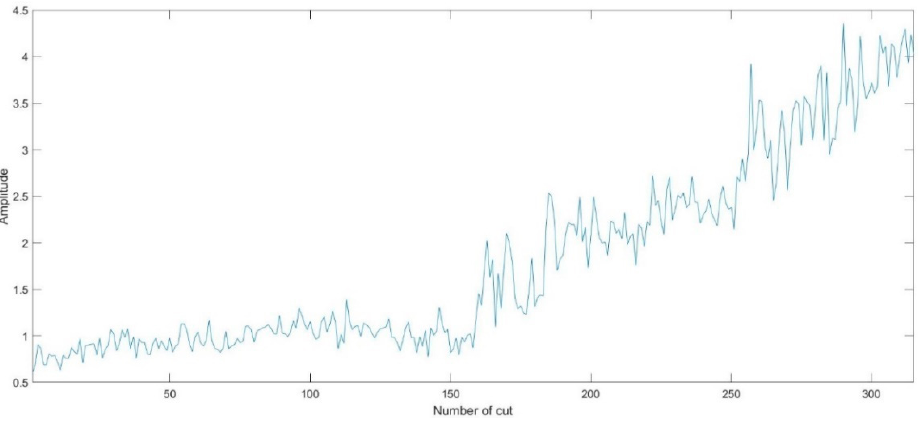
Figure 6. Time-dependent trend chart for Gn of vibration signals in the milling process.